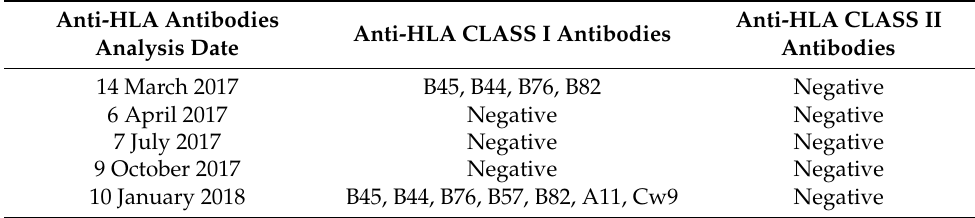
Table 1. Results of the identification of anti-HLA antibodies against class I and II, carried out on the patient during the time on the waiting list for kidney transplantation.